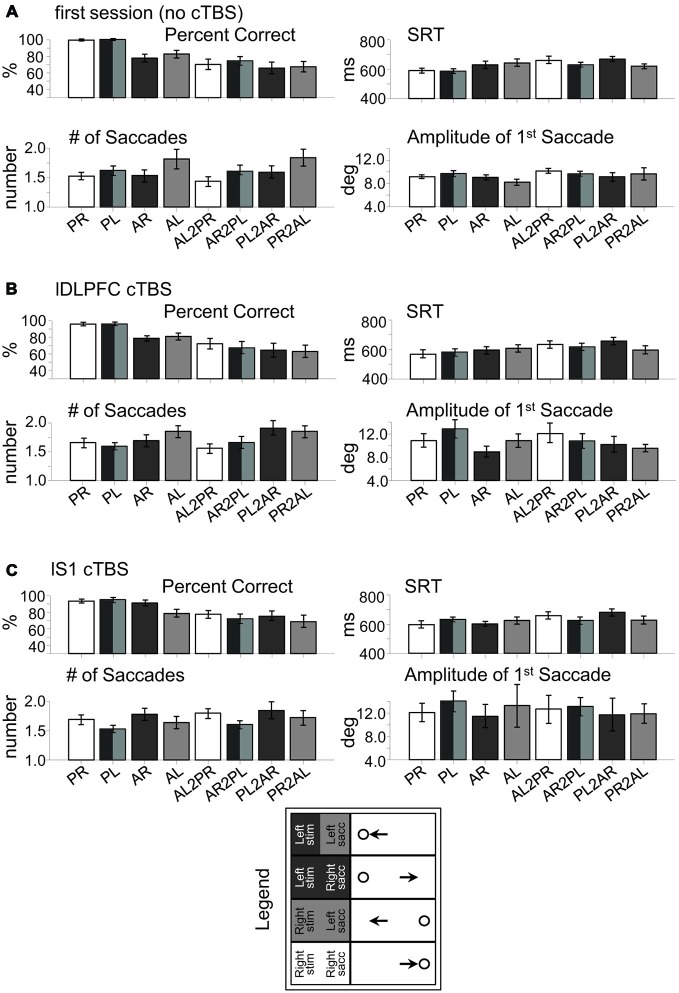
Raw behavioral data in lDLPFC study. (A) Session 1 (no cTBS). (B) lDLPFC cTBS. (C) lS1 cTBS. Conventions are as in Figure 4.